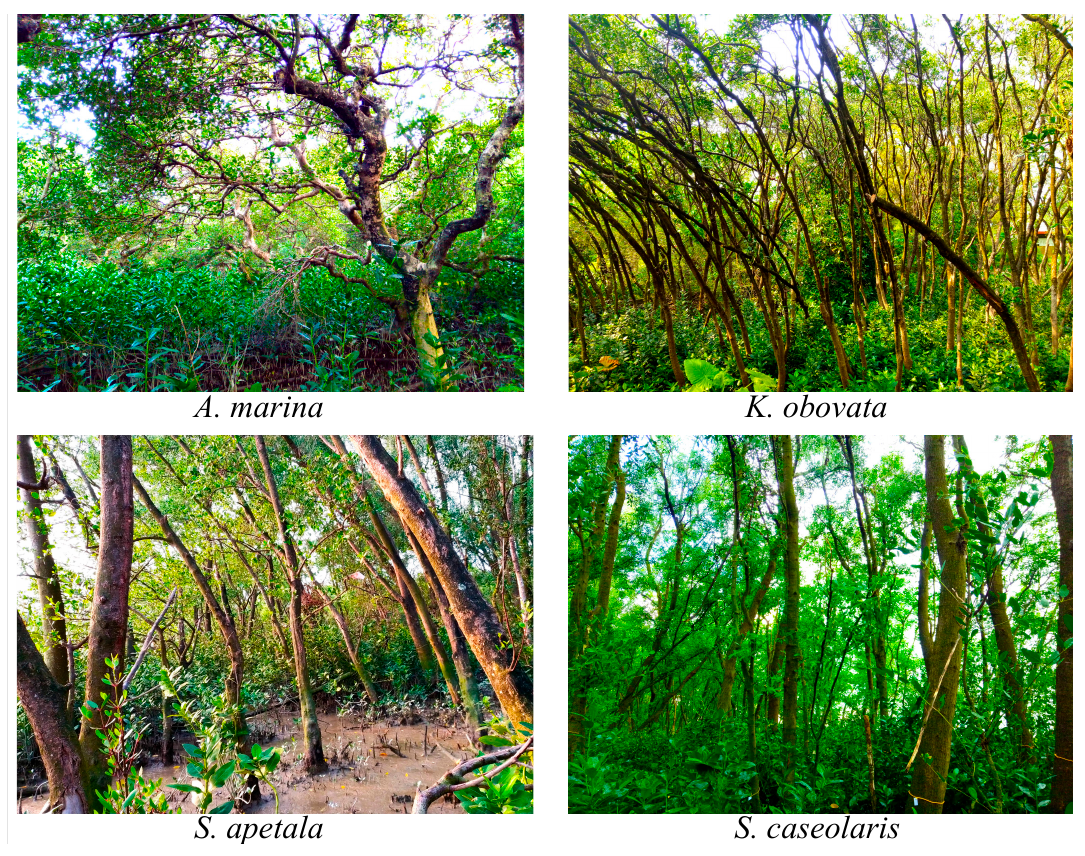
Figure A3. Photos of mangrove assemblages. Table A1. Confusion matrix of the mangrove species classification for the UAV orthoimage. Mangrove